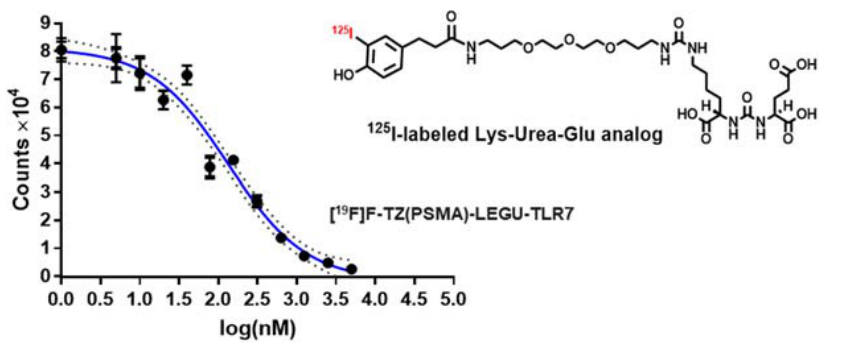
Figure 1. Competitive PSMA binding affinity measurement of [ 19 F]F-TZ(PSMA)-LEGU-TLR7 using PSMA + PC3-PIP cells and competitive radioligand 125 I-labeled Lys-Urea-Glu. The IC 50 values was measured to be 134 ± 37 nM by nonlinear regression of the data fitting using GraphPad Prism 7.04 (coefficient of determination R 2 = 0.97). Data presented as counts ± s.d. ( n = 3).